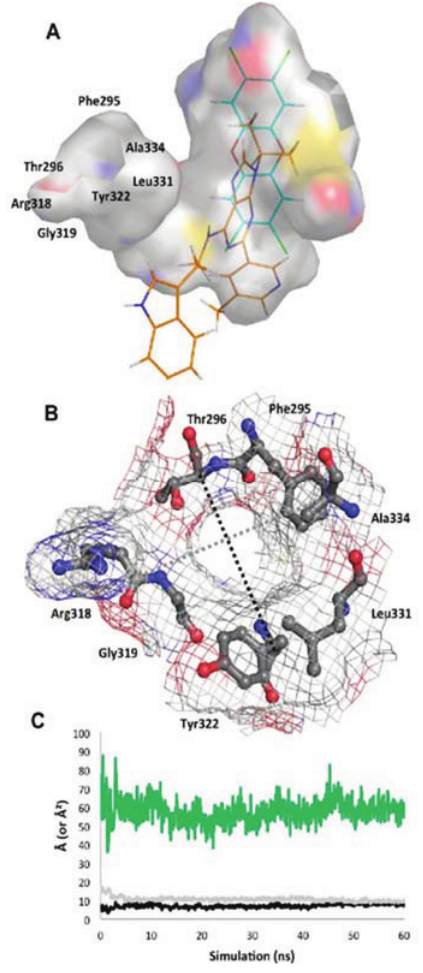
Figure 10. Structure of the apo binding pocket. ( A ) The environment of the ligand cavity is shown for apo MD (at 60 ns) colored by atom: carbon, grey; oxygen, red; nitrogen, blue; sulfur, yellow with the pocket area calculated as in Figure 2. The ligands of the agonist MD (cyan) and antagonist MD (orange) models are superimposed as lines. ( B ) Seven residues constituting the entrance to the binding site are noted. The pocket entrance is shown, with delineating residues displayed as sticks and surface displayed as mesh colored by atom. ( C ) The approximate size of the pocket entrance over time is shown, estimated by plotting in Å the molecular surface gap (distance between atoms subtracted by molecular surface) between the C(cid:2) atoms of residues Ala334 and Arg318 (grey line in b) and Thr296 and Tyr322 (black line in b); the area of the ellipse that would be formed by these two distances is plotted in green in Å 2